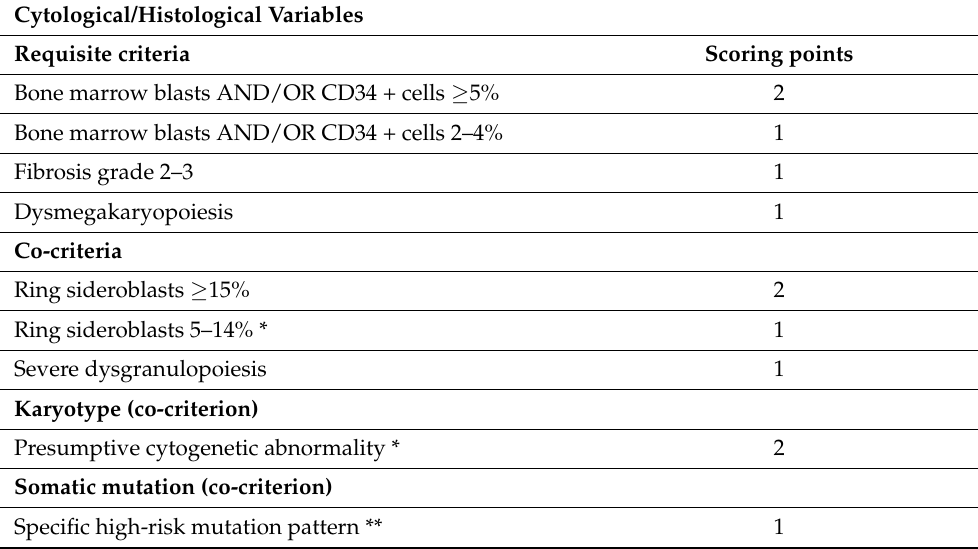
Table 3. Integrated cyto-histologic/genetic score (hg-score) for distinction of hypoplastic myelodys- plastic syndrome (hMDS) and aplastic anemia (AA)